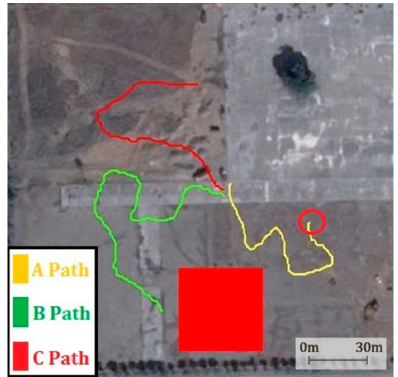
Figure 20. Trajectories at the moment Car-A failed (the red circle).